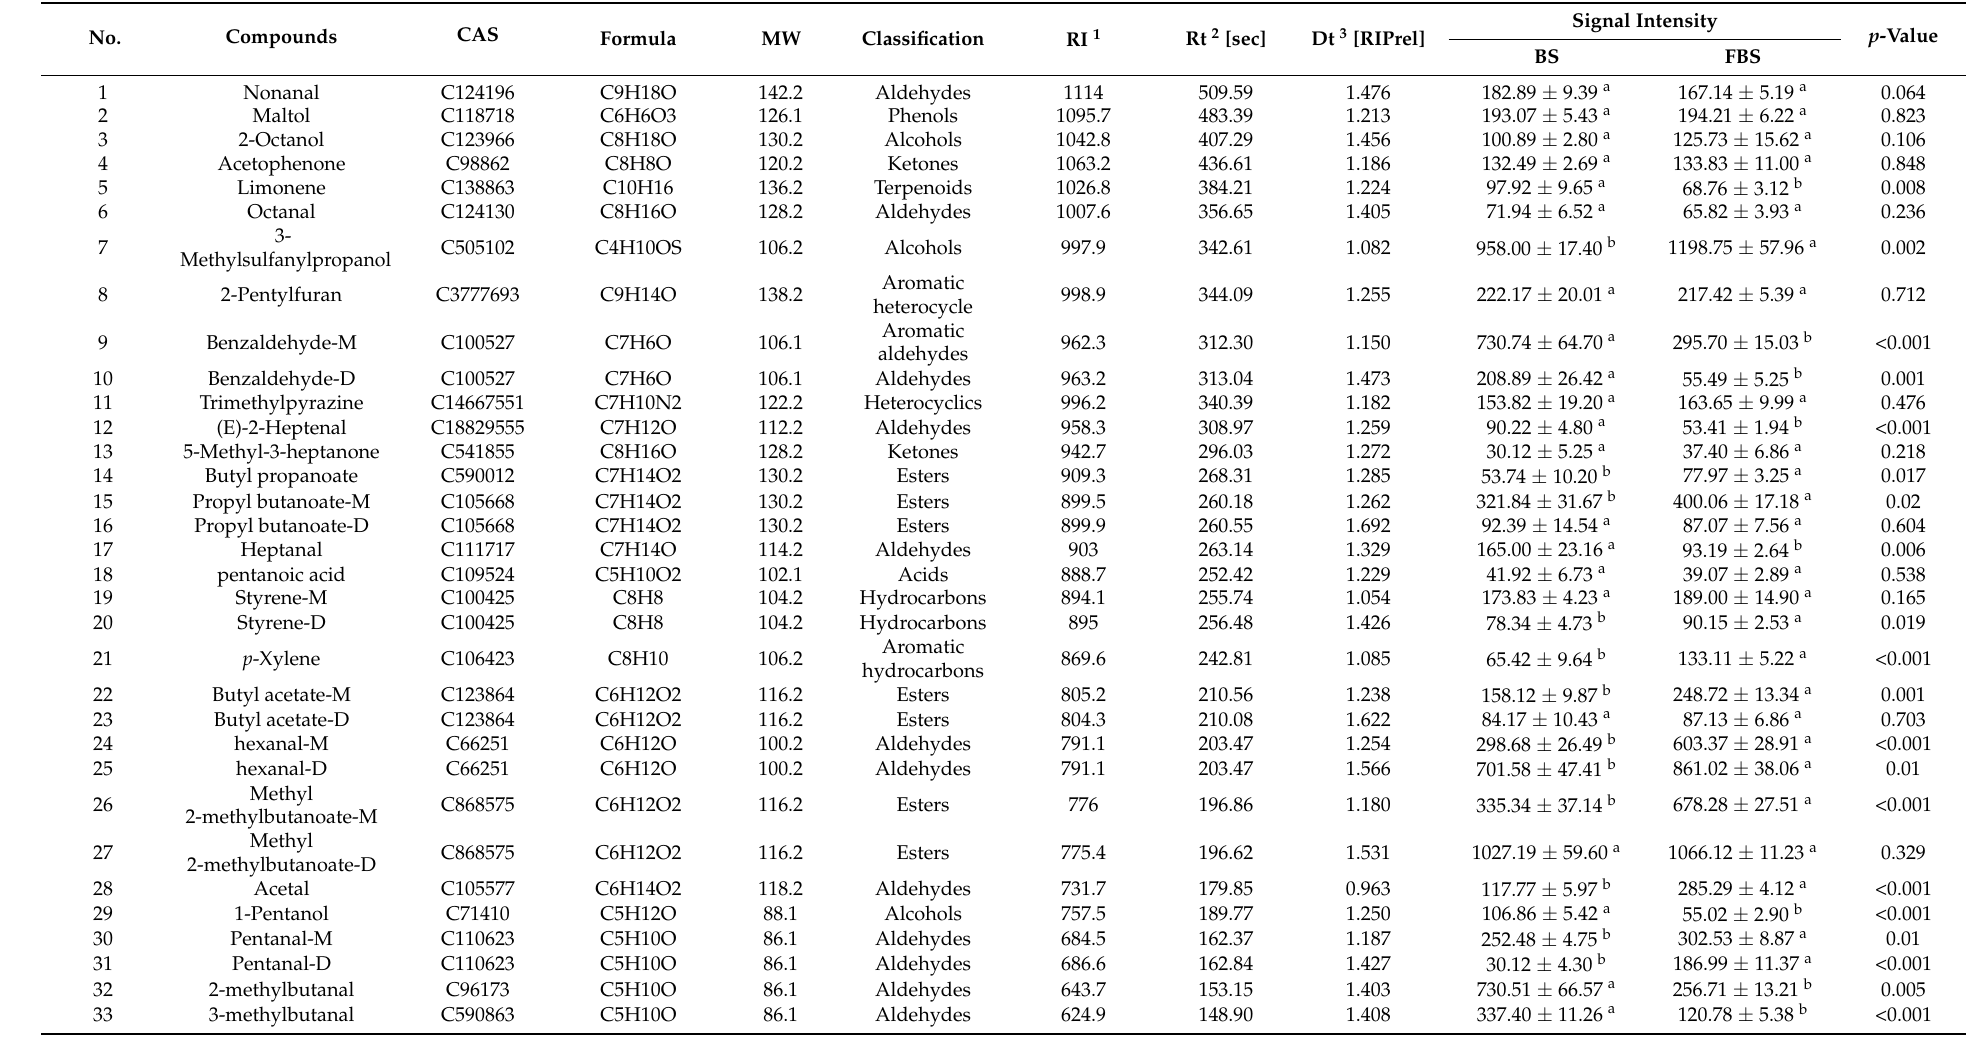
Table 7. GC-IMS integration parameters of volatile compounds detected in E . cristatum -fermented and non-fermented black soybeans by